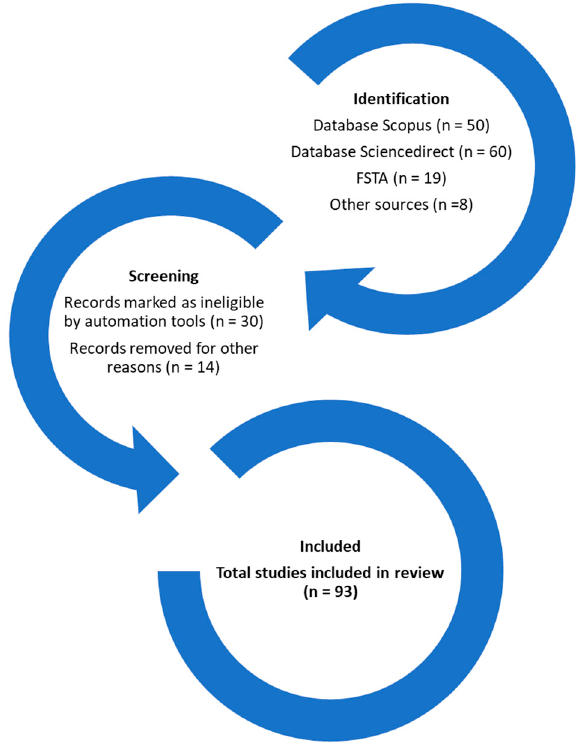
Figure 1. Diagram of selection of scientific publications.